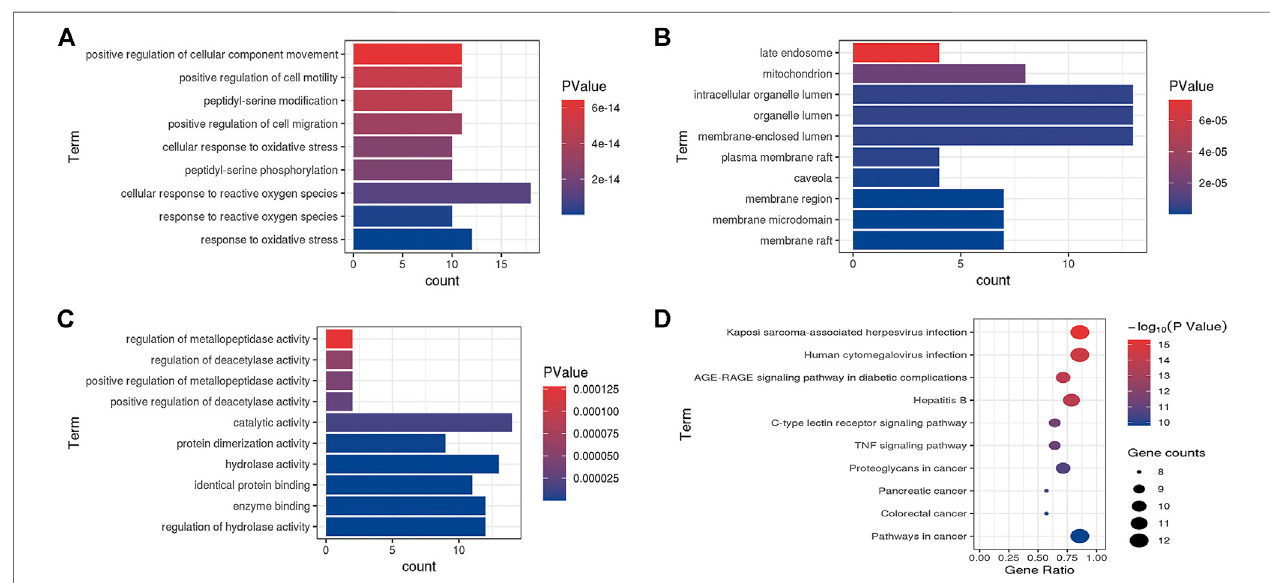
FIGURE3| Goenrichedtermsofpotentialtargetsforbiologicalprocesses (A) ,cellularcomponents (B) andmolecularfunctions (C) andKEGGenrichedterms (D) .